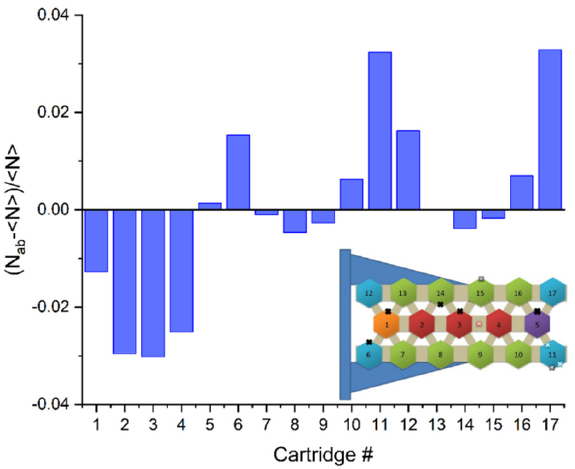
Figure 23. Comparison of the gas loads individually caught by the different cartridges (for numbering, see inlay or Figure 5) in the ProVac3D model. Nab is the number of particles caught by a cartridge and <N> is the average number of caught particles for all cartridges. It can be seen that the shadowing effects between the cartridges are very small with a 3% maximum.